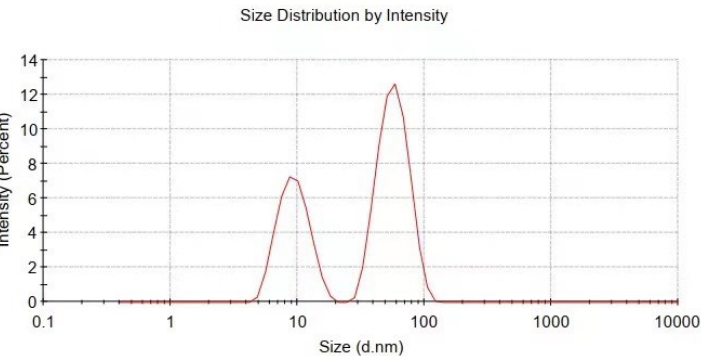
Figure 3. XRD patterns of Cu@organic (red) and Cu@MC (black).